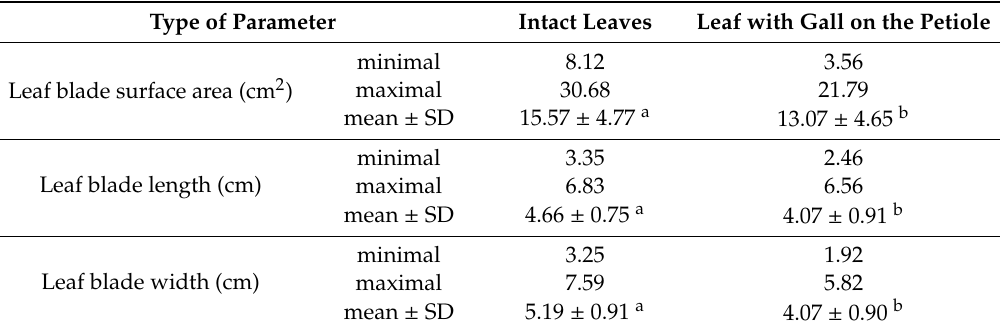
Table 2. E ff ect of P. spyrothecae galls on metric parameters of Populus nigra “Italica” leaves. Type of Parameter Intact Leaves Leaf with Gall on the Petiole minimal Leaf blade surface area (cm 2 )